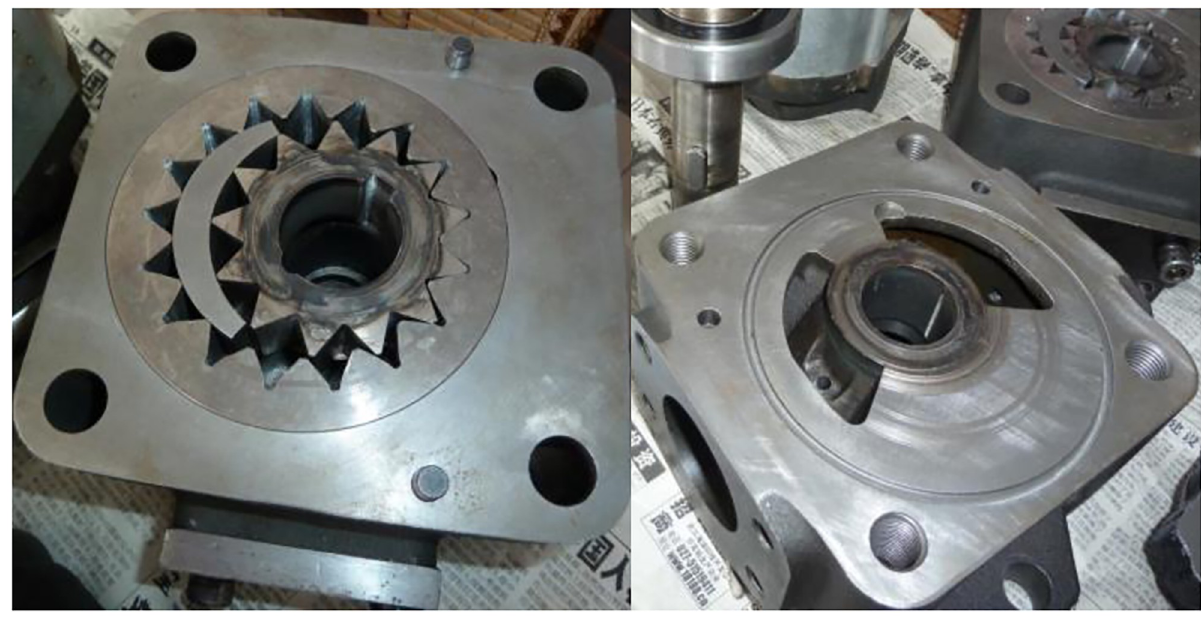
Fig 17. Prototype corresponding to the optimal